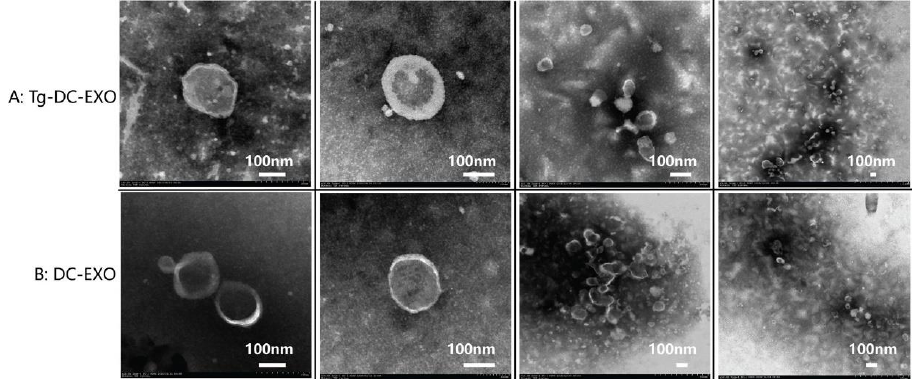
Figure 2. Detection of exosomal extracts with transmission electron microscope (TEM). The exosomes were visualized under a transmission electronic microscope (Hitachi, Northeastern Honshu, Japan) at 80 kV voltage, with a magnification of 10K–30K. ( A ) Exosomes extracted from the DC2.4 cells infected with T. gondii RH tachyzoites (MOI = 3) for 28 h. ( B ) Exosomes extracted from DC2.4 cells after 28 h culturing. Obviously, the tea-tray-like structure was observed under a TEM.